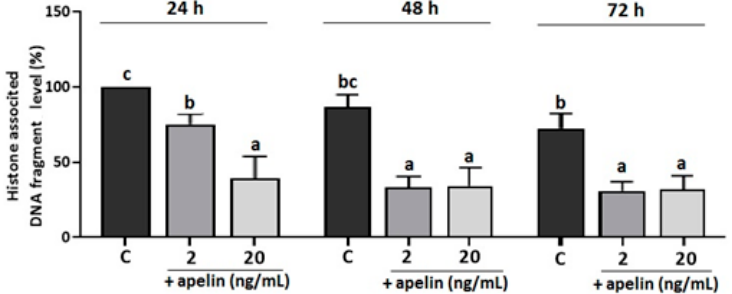
Figure 5. Effect of apelin on DNA fragmentation in villous explants from human placenta. The explants were incubated with apelin at 2 and 20 ng/mL for 24, 48 and 72 h, and the level of histone-associated DNA fragment was measured using the Cell Death Detection ELISA kit. Experiments were performed on five independent cultures of human placenta explants ( n = 5). The level of DNA fragmentation was calculated to 100 µ g protein of villous explants and then as percentage compared to the 24-h control sample (100%). The data are arranged as means ± SEM. Different letters indicate significant differences ( p < 0.05) among groups; Control